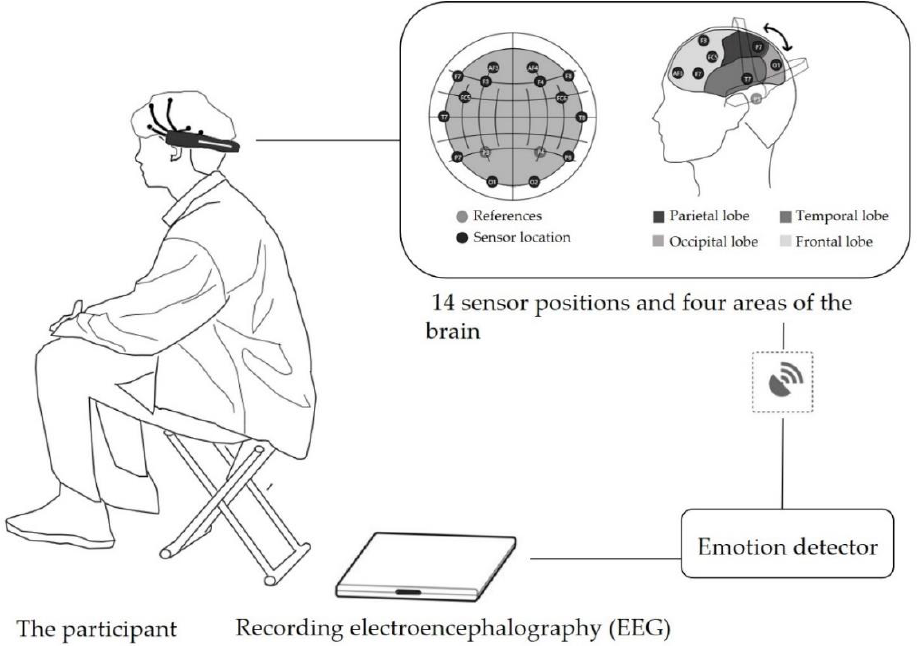
Figure 3. Participant wearing Emotiv EPOC + and the four covered brain